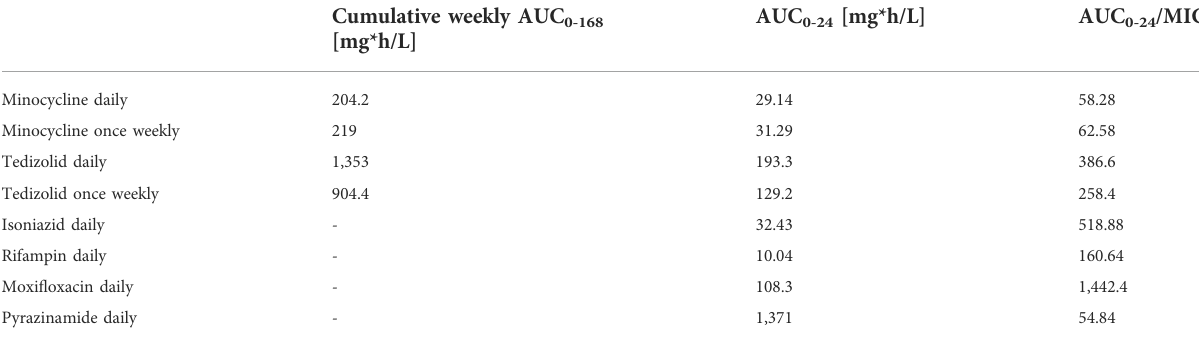
TABLE 1 Drug exposures of antibiotics achieved in the HFS-TB